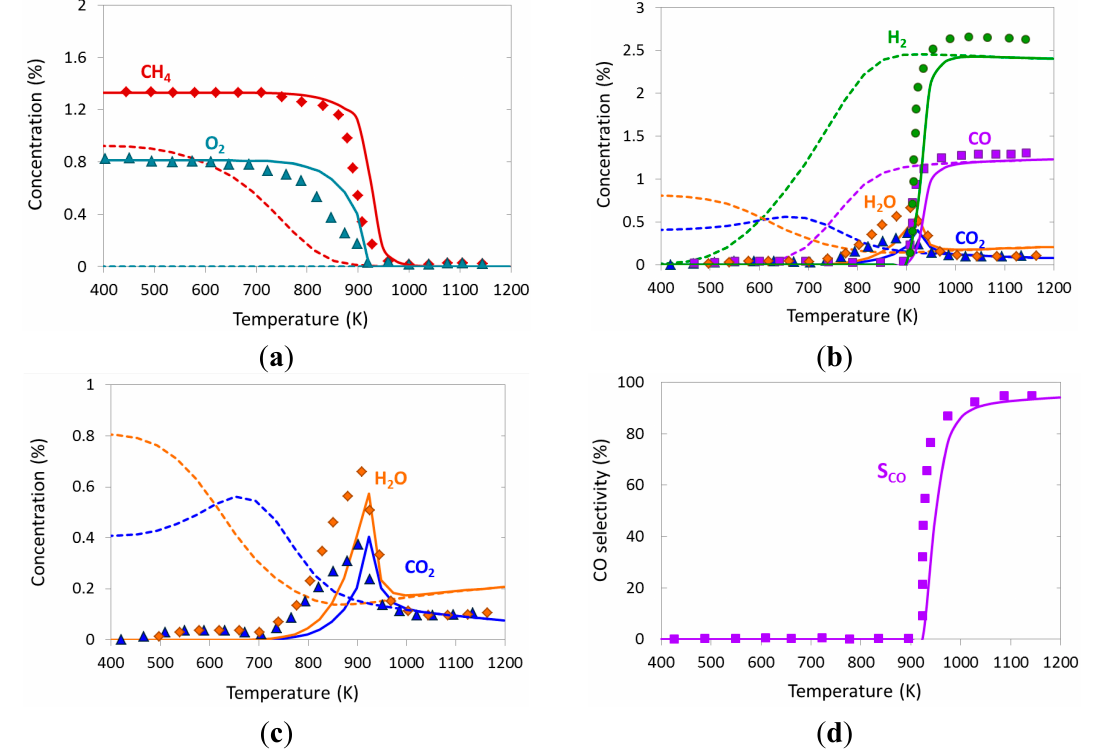
Figure 3. Comparison of experimentally determined (symbols) and numerically predicted (lines) concentrations as a function of temperature for catalytic partial oxidation of methane in a fixed bed reactor: ( a ) reactants; ( b ) products; ( c ) zoom-in of CO 2 and H 2 O formation; ( d ) selectivity of CO; inlet gas composition of CH 4 /O 2 = 1.6 in N 2 ; 1 bar; T inlet = 373 K; total flow rate of 4 slpm; dashed lines = equilibrium composition at given